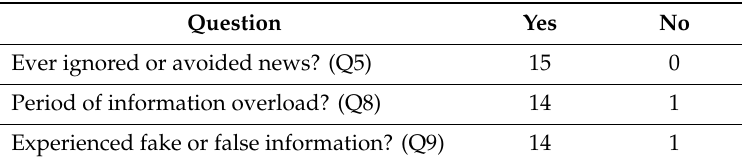
Table 4. Ignore / avoid; overload; fake / false